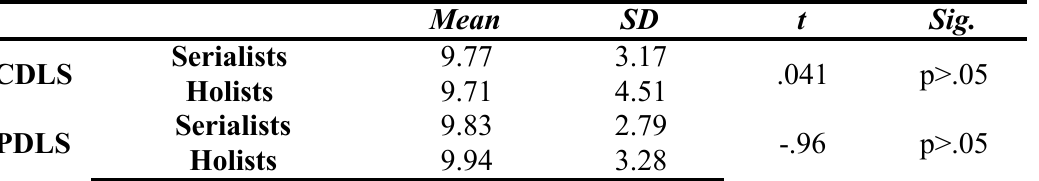
Overall Learning